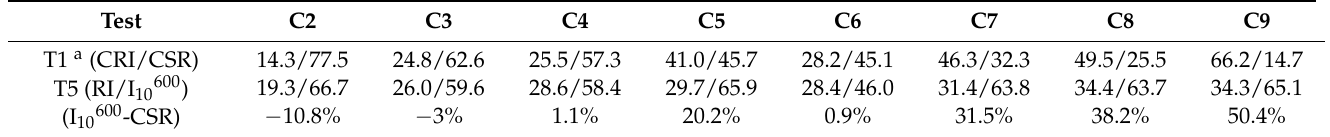
Table 3. The results of RI/I 10600 (%/%) for pilot cokes from single coals under high temperature and standard conditions.